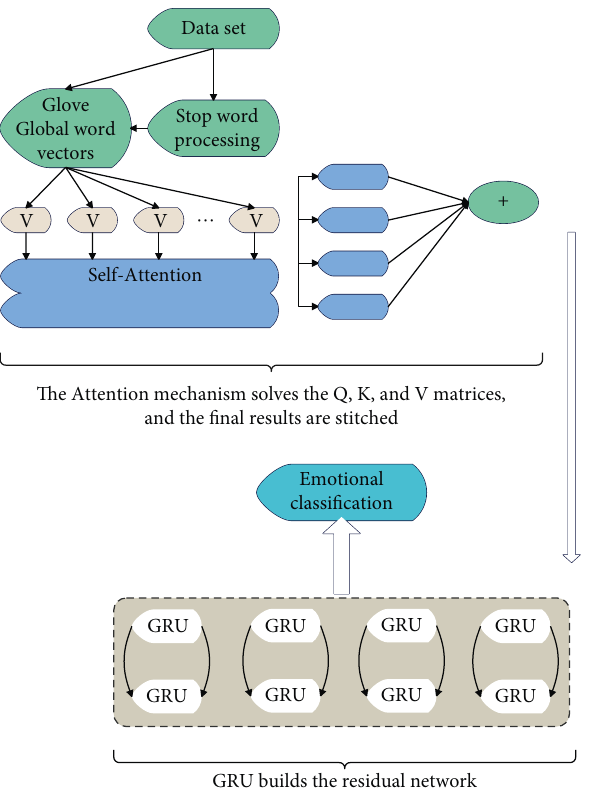
Figure 7: Structure diagram of SABG